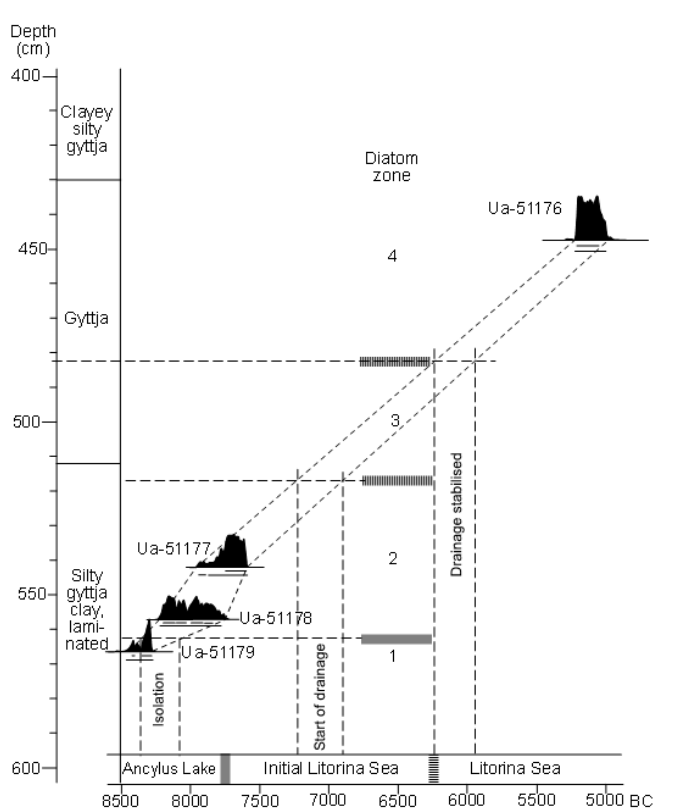
Figure 4. Chronology and sediment stratigraphy of sediment core from Karsviken in Lake Boren. Age-depth interval is based on linear interpolation of 14 C-dates (2 σ error).